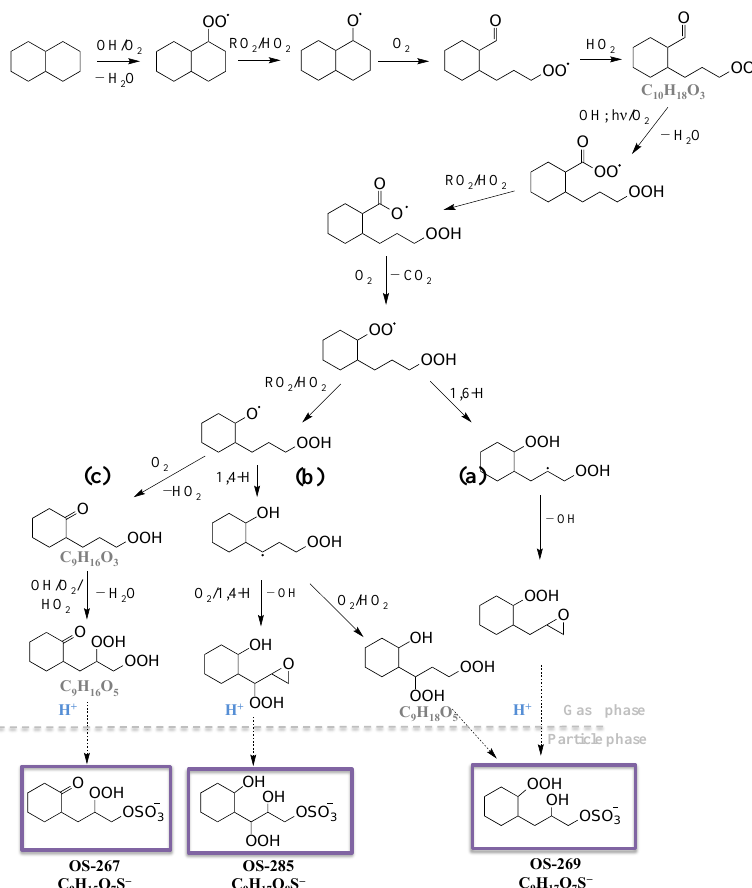
Figure 3. Tentatively proposed formation pathways of OS-267 ( m/z 267.9552), OS-269 ( m/z 269.0696) and OS-285 (285.0654) from the oxidation of decalin in presence of sulfate aerosol.